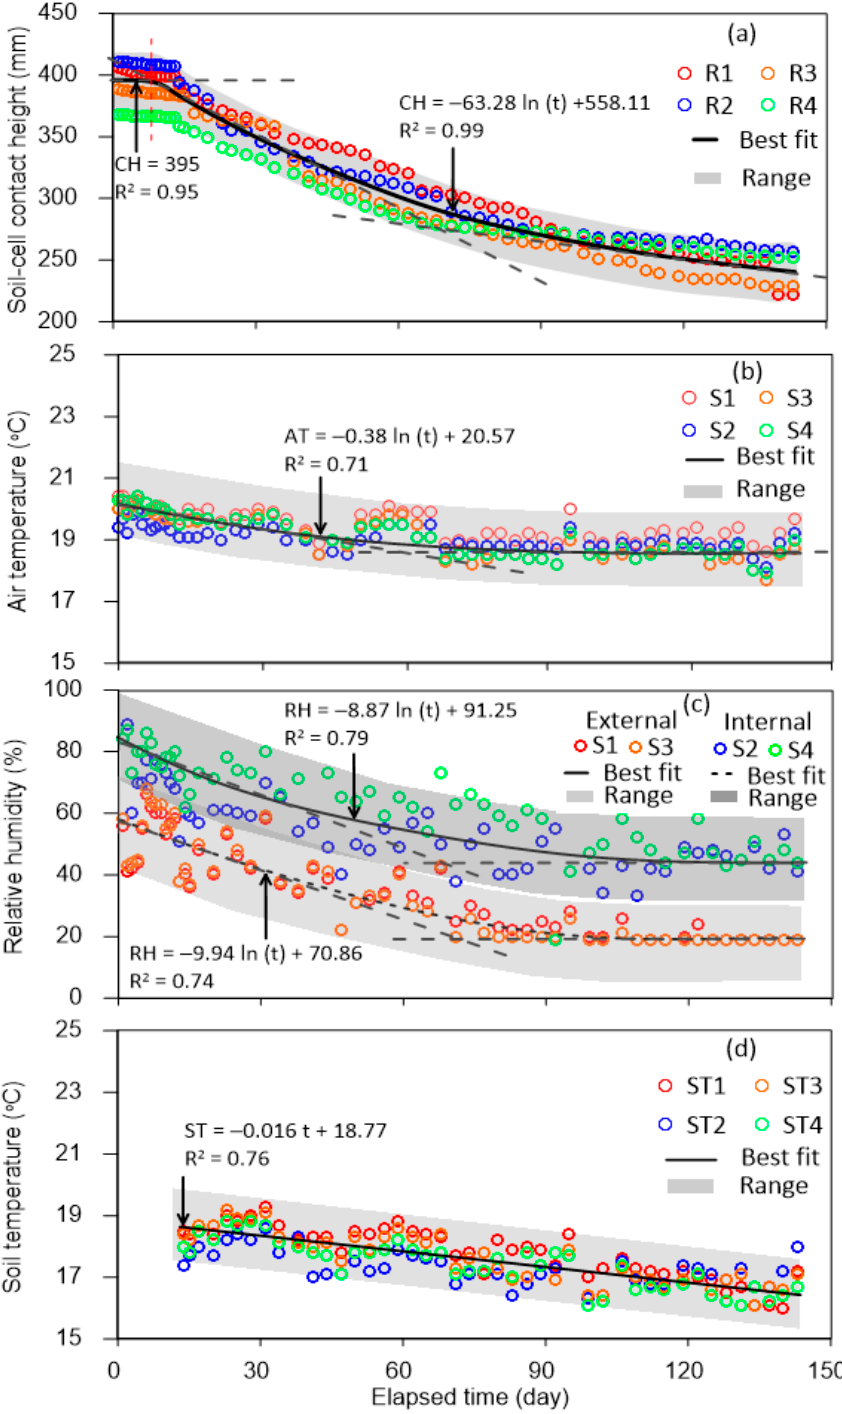
Figure 5. Transient changes during shrinkage test in large cell: ( a ) soil–cell contact height; ( b ) air temperature; ( c ) relative humidity; and ( d ) soil temperature.